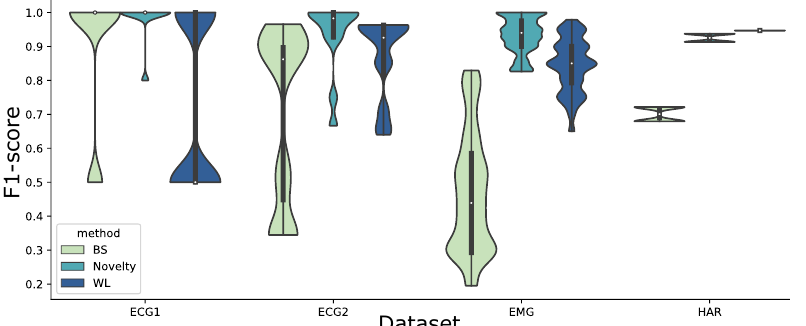
Figure A1. F1-scores’ distribution for three segmentation methods on Datasets 1–4. WS: window- based segmentation; BS: binary segmentation; Novelty: the proposed novelty function- based